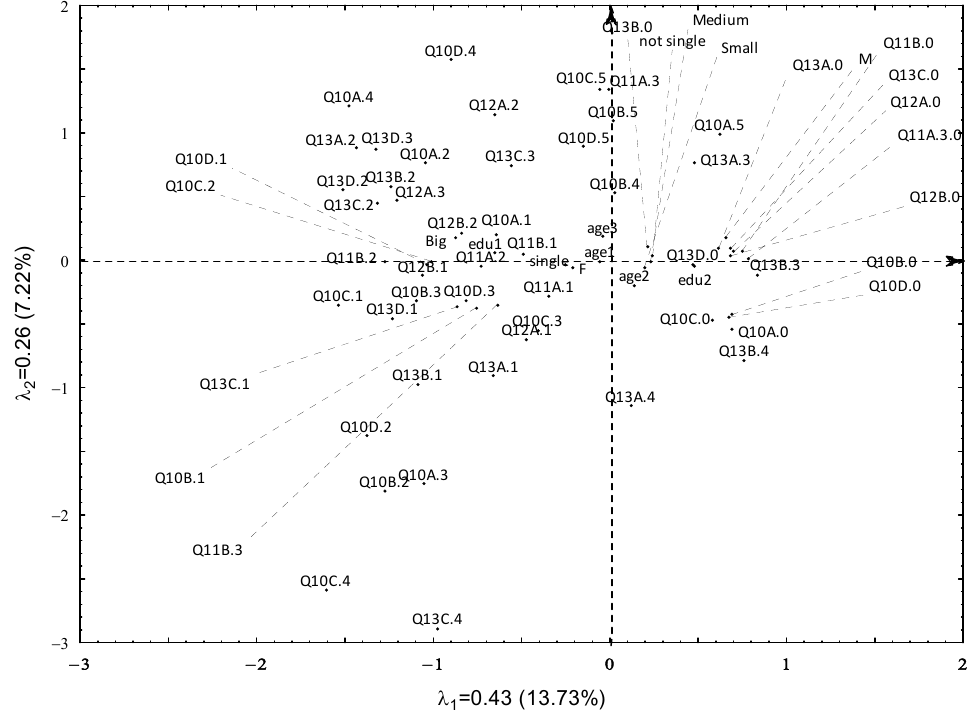
Figure 3. Seniors travel preferences. Source: Own computation using Statistica13.